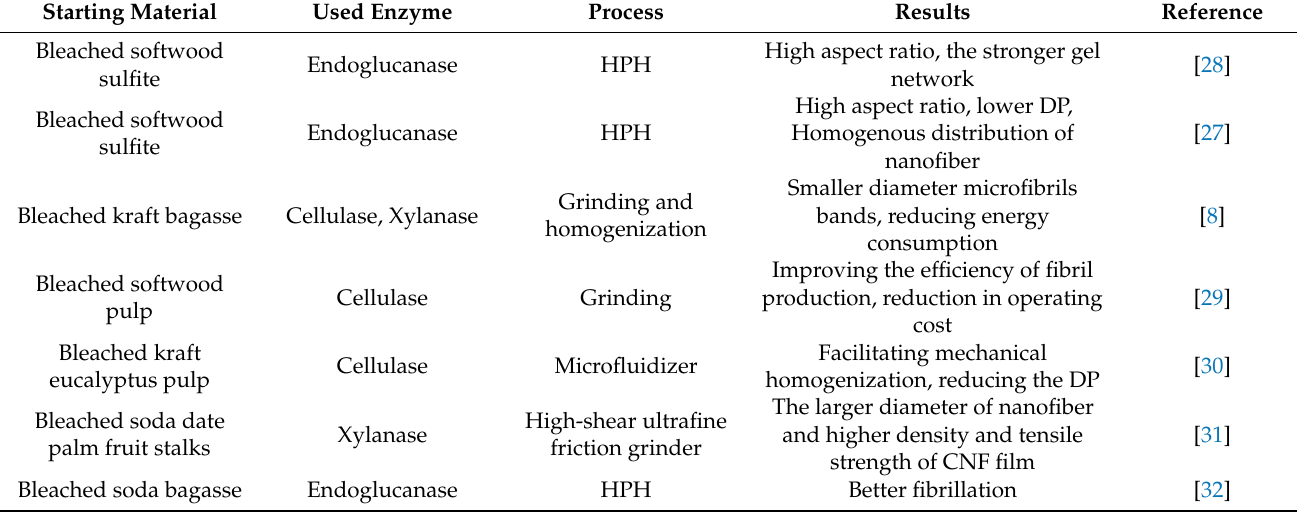
Table 4. Different enzymes employed to pretreat the cellulose fibers on various raw materials before mechanical fibrillation for the production of